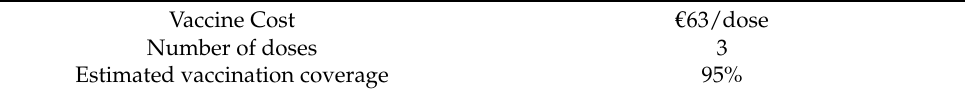
Table 2. Parameters considered in the economic model and related to vaccine cost, vaccination strategy ( n ◦ of doses), and estimated vaccination coverage.